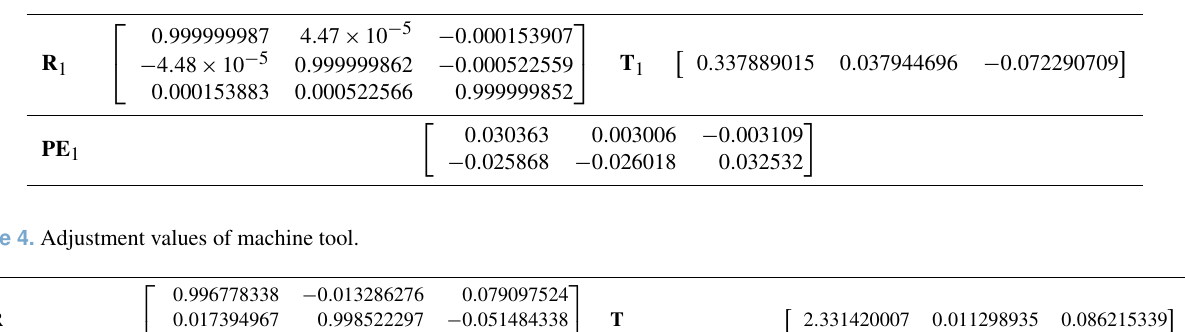
Table 3. The fine matching matrixes of the SADE algorithm.